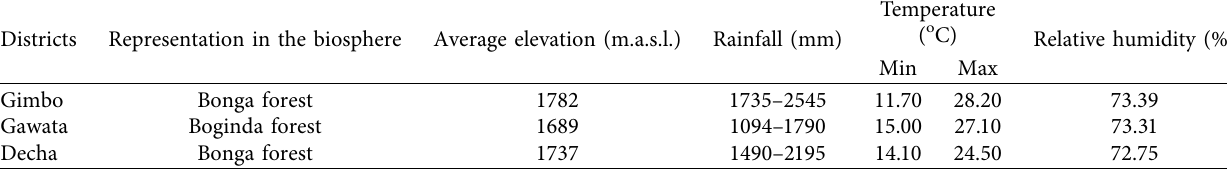
Table 1: Environmental description of districts prioritizing sampling locations.